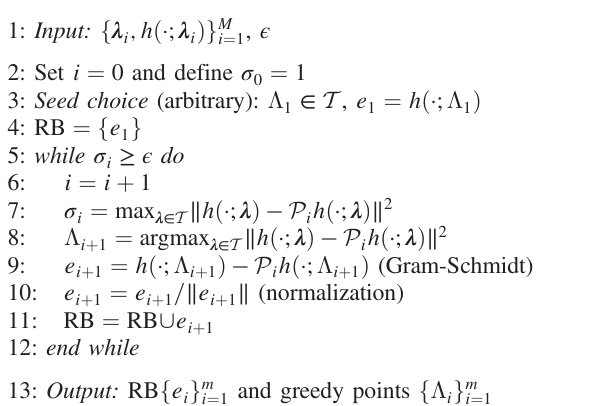
Algorithm 1 : Greedy algorithm for reduced